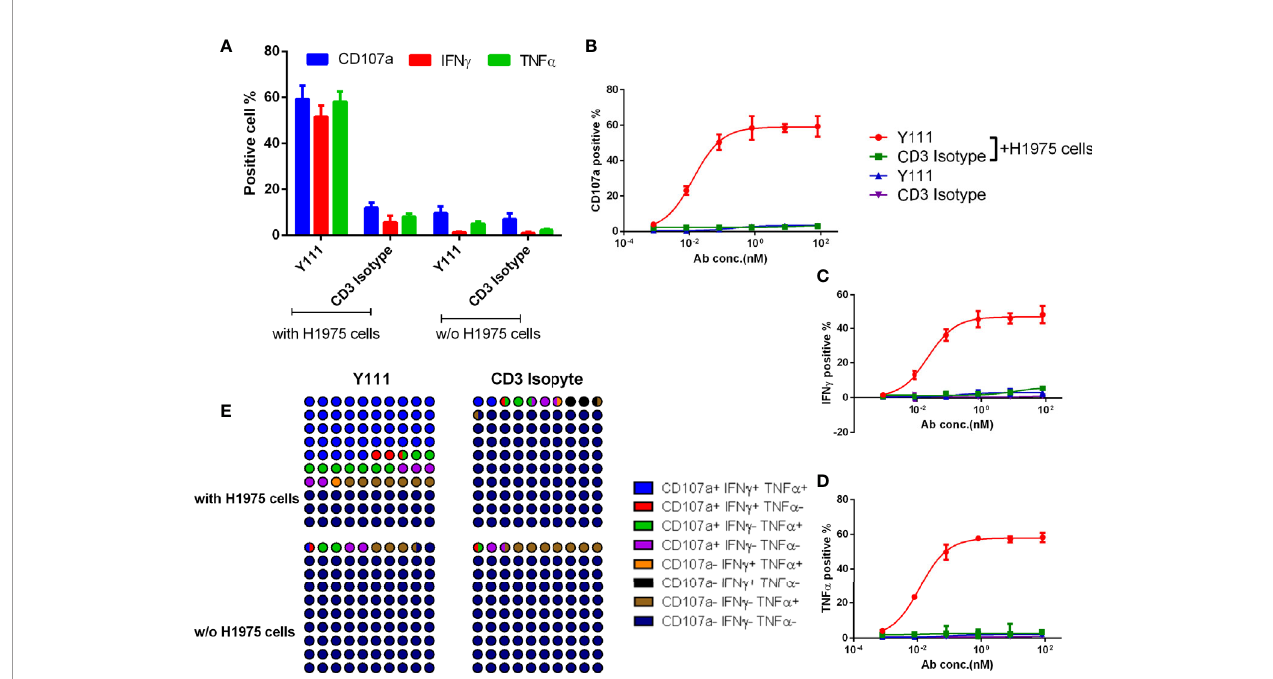
FIGURE 4 | Y111 selectively triggered the cytokine production and degranulation of V g 2V d 2 T cells in the presence of target tumor cells. (A-D) Y111 ef fi ciently enhanced the activation of V g 2V d 2 T cells to produce IFN g , TNF a , and up-regulate CD107a in tumor cell-dependent fashion. V g 2V d 2 T cells were stimulated by Y111 or CD3 Isotype (1 m g/mL of each) (A) , and indicated concentration ranges of Y111 or CD3 Isotype (B – D) in the presence/absence of H1975 cells in a 1:1 ratio for 6 hours. (E) Part of the whole graph shown the co-expression signatures of V g 2V d 2 T cells treated by Y111 or CD3 Isotype (1 m g/mL of each) in the presence or absence of H1975 cells. After gating cytokine-positive population ( Supplementary Figure 4 ), the boolean analysis was utilized to determine the percentages of multi-functional effector subsets of V g 2V d 2 T cells. Bar graph data shown in (A) were represented as means ± SEM pooled from three experiments involving 9 healthy donors, dots in (B – D) were the means of these individual donors. The data in (B) were analyzed using the “ log (agonist) vs. response (three parameters) ” plot through an ordinary fi